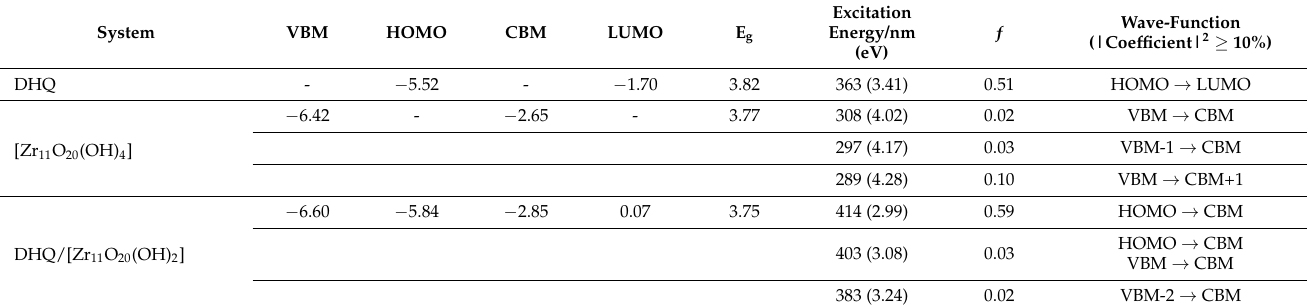
Table 1. The energies of frontier orbitals (eV) of DHQ, [Zr 11 O 20 (OH) 4 ], and DHQ/[Zr 11 O 20 (OH) 2 ] cluster, the bandgap (E g ), as well as excitation energies, and the oscillator strength (ƒ) of the first three transitions calculated at TD-DFT/CAM-B3LYP/6-31G(d,p) level. Wave-functions and contributions to the electronic transitions are presented in the last column. HOMO/LUMO denote DHQ’s orbitals, while VBM and CBM are used for ZrO 2 -centered orbitals.